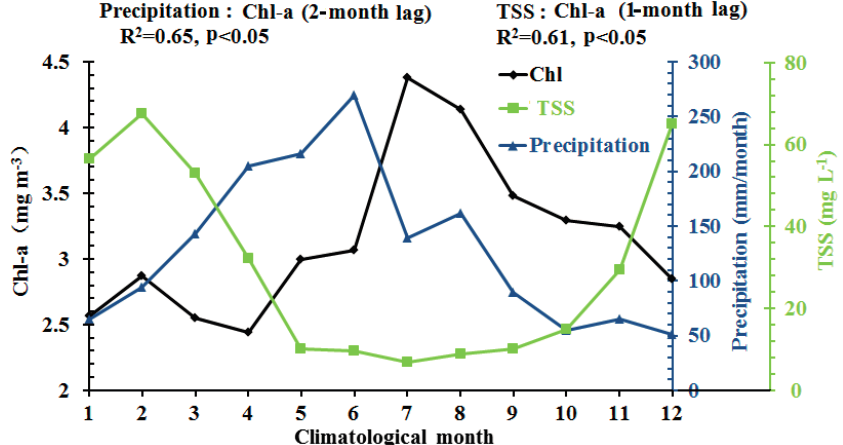
Figure 11. Mean Chl-a of each climatological month during 2003 and 2011. Also plotted